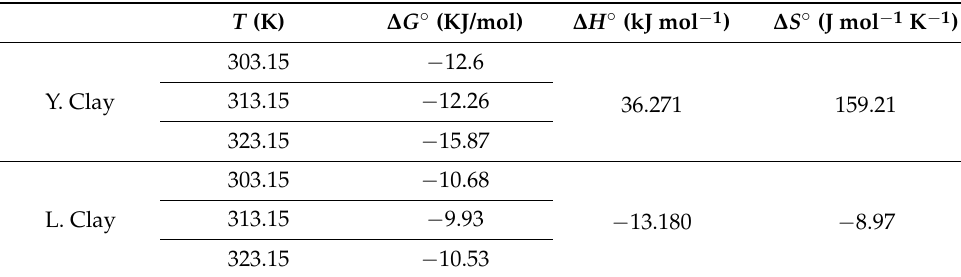
Table 6. Thermodynamic parameters of crystal violet dye adsorption onto Clay at different tempera- tures (303.15–323.15 K).